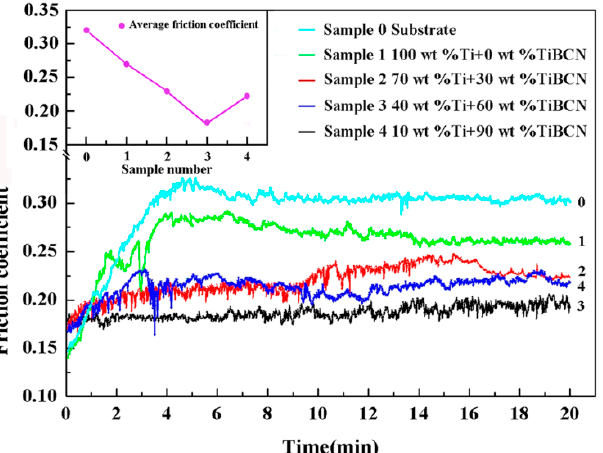
Figure 6. Microhardness and polarization curve of Ti/TiBCN composite coatings with the different TiBCN contents. ( a ) Microhardness, and ( b ) polarization curve.